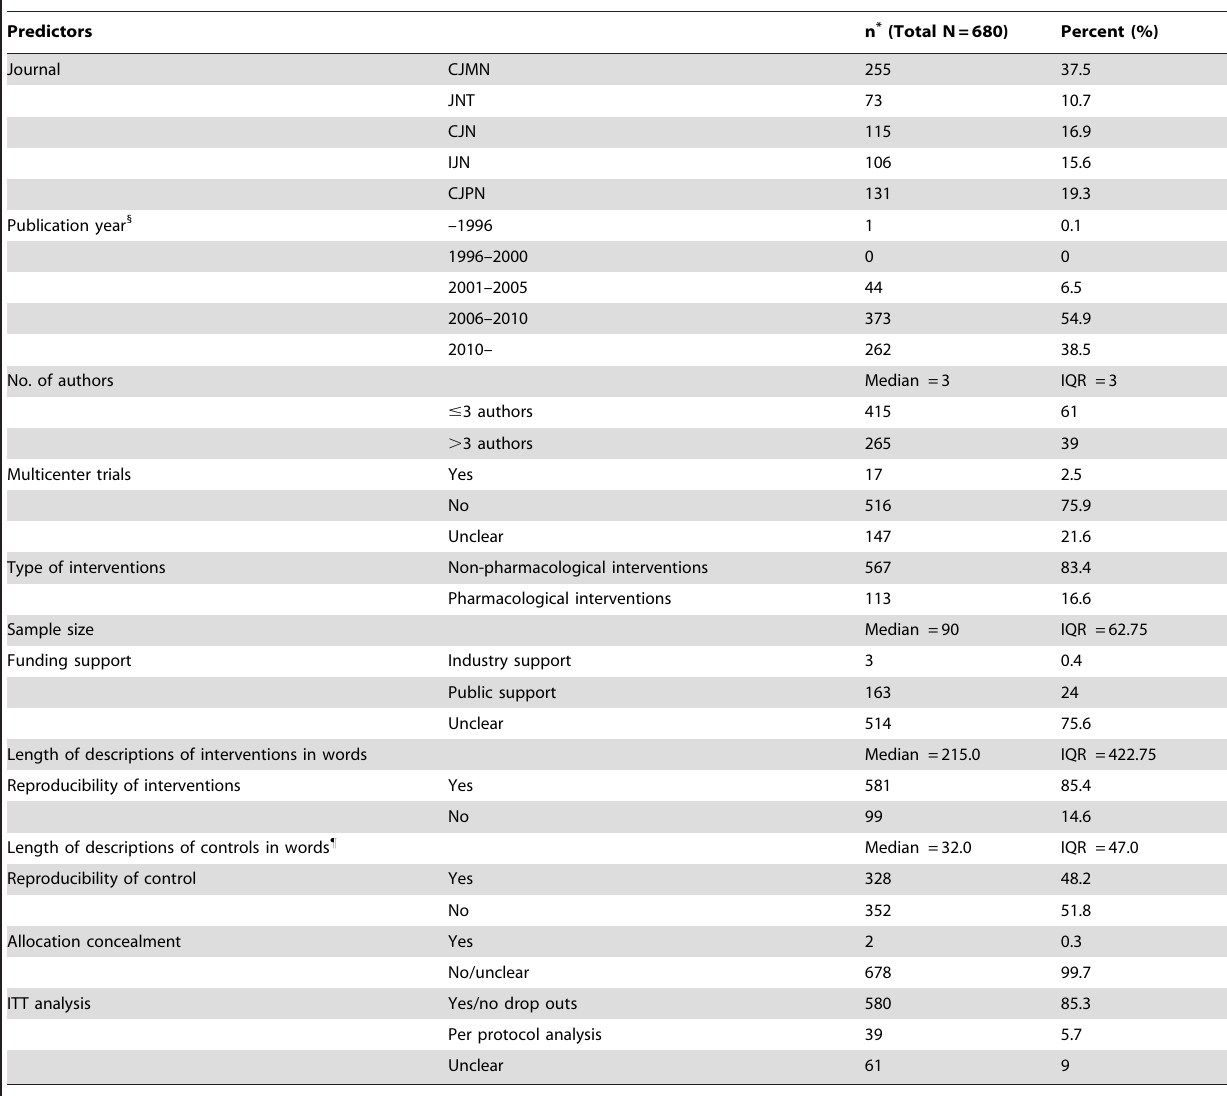
Table 1. Characteristics of Included